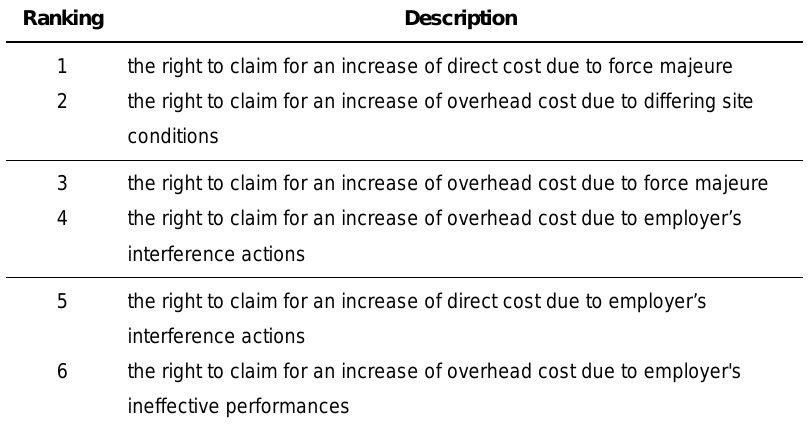
Table 4: Ranking of the claiming rights by the level of willingness of Thai